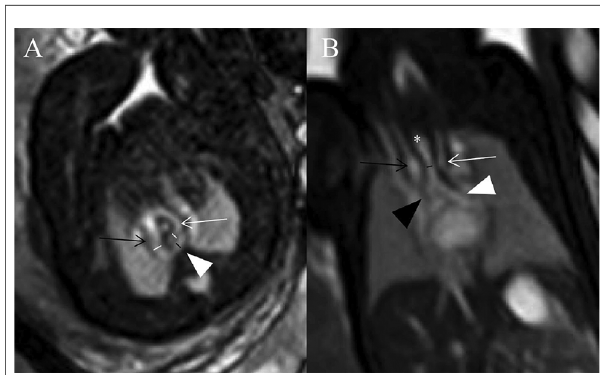
FIGURE 2 ( A,B ) Diagrams of measuring the diameters of AoI, DA, and tracheal in a 29 weeks ’ gestation fetus with DAA. ( A ) Measurements of AoI and DA diameter in the transverse view of AA. Fetal cardiovascular magnetic resonance SSFP sequence transverse view of AA image showed AoI (white lines) and DA (black line) diameter measured, right aortic arch (black open arrow), left aortic arch (white open arrow), left-sided DA (white arrowhead); ( B ) measurement of tracheal diameter on the coronal view. Fetal cardiovascular magnetic resonance SSFP sequence coronal view image showed the trachea (white asterisk), tracheal diameter measured (black line), right aortic arch (black open arrow), left aortic arch (white open arrow), right principal bronchus (black arrowhead), left principal bronchus (white